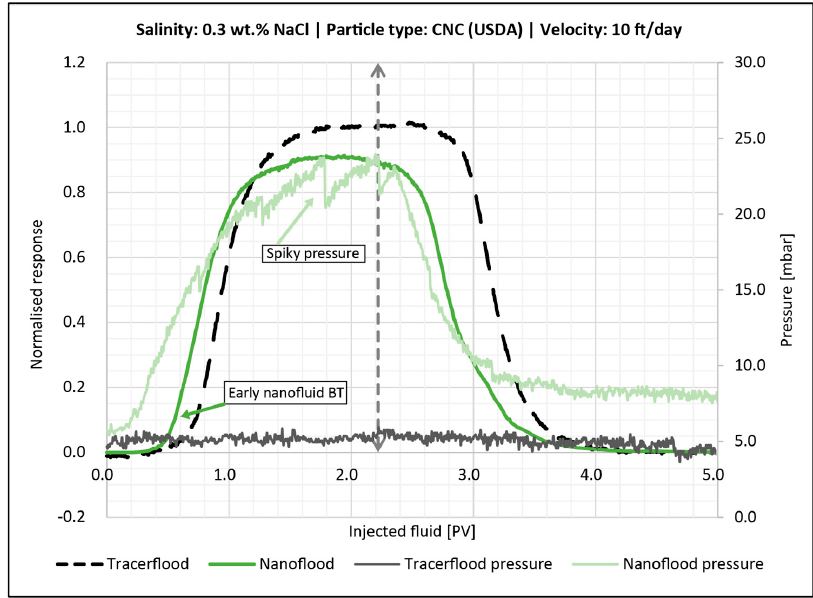
Figure 17. Breakthrough curve for the core flood with 0.5 wt. % CNC (USDA) in 0.3 wt. % NaCl (green line). 2.2 PV were injected followed by 0.3 wt. % brine. The dashed vertical line illustrates when post flush was started. The tracer BT-curve is the black dotted line. The corresponding pressure curves are also shown.